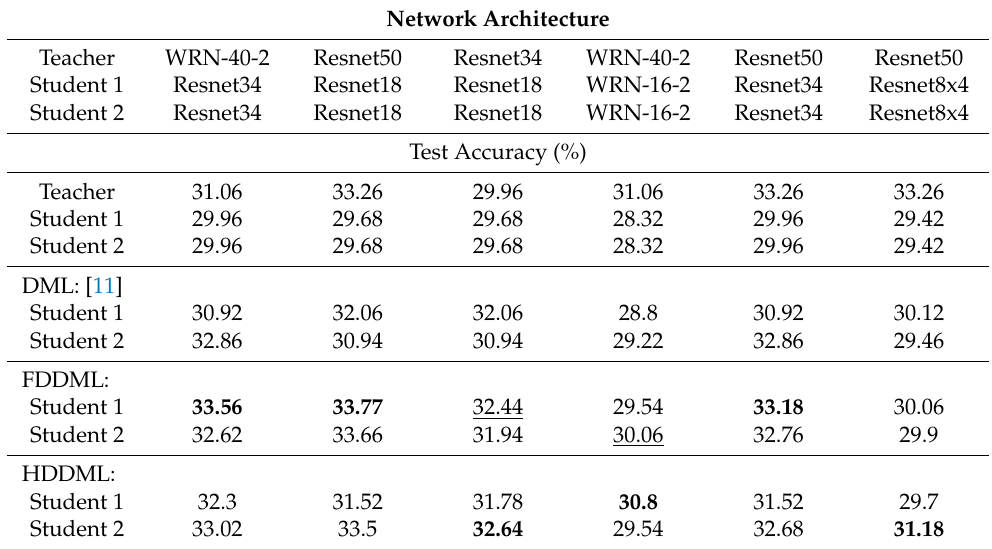
Table 5. Comparing results top-1 accuracy on The TinyImageNet datasets resize with 32-image